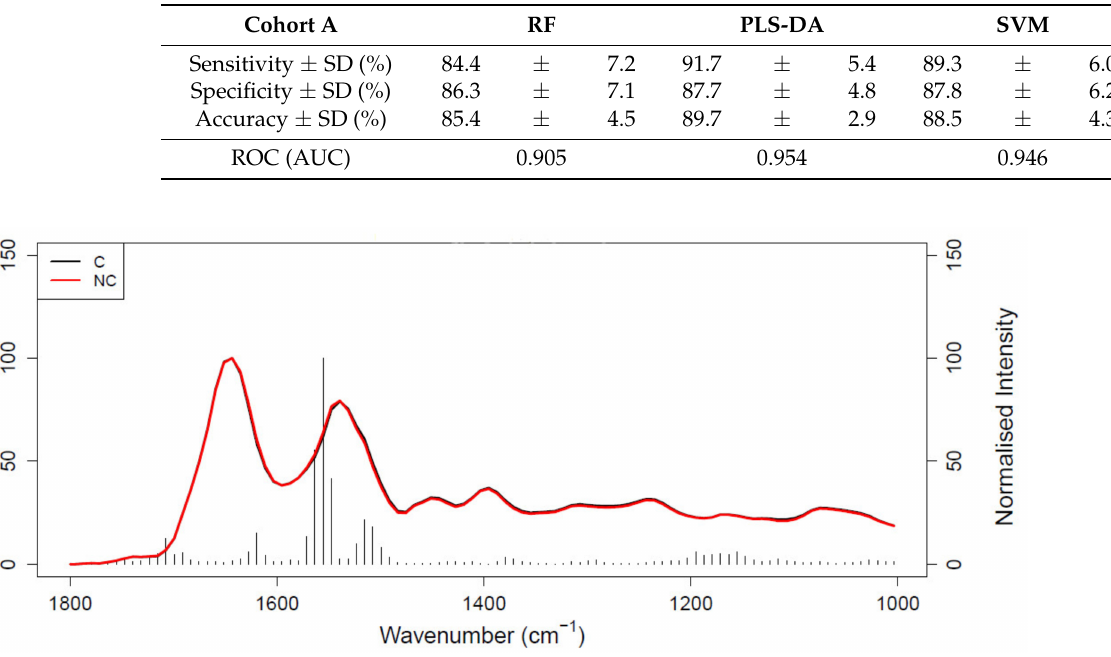
Figure 2. Gini importance plot of random forest (RF) analysis performed on Cohort A; C (black) represents the pancreatic cancer spectrum and NC (red) represents the healthy control